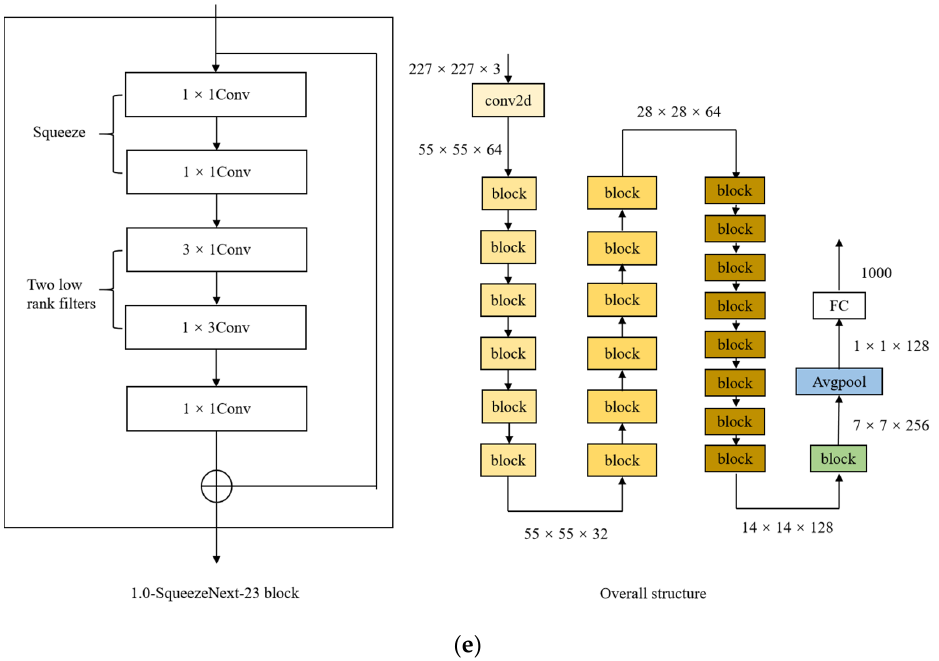
Figure A2. Structure of the main building blocks and overall structure of common lightweight CNNs. ( a ) Structure of MobileNet_V1; ( b ) structure of MobileNet_V2; ( c ) structure of ShuffleNet_V1; ( d ) structure of ShuffleNet_V2; ( e ) structure of 1.0-SqueezeNext-23.